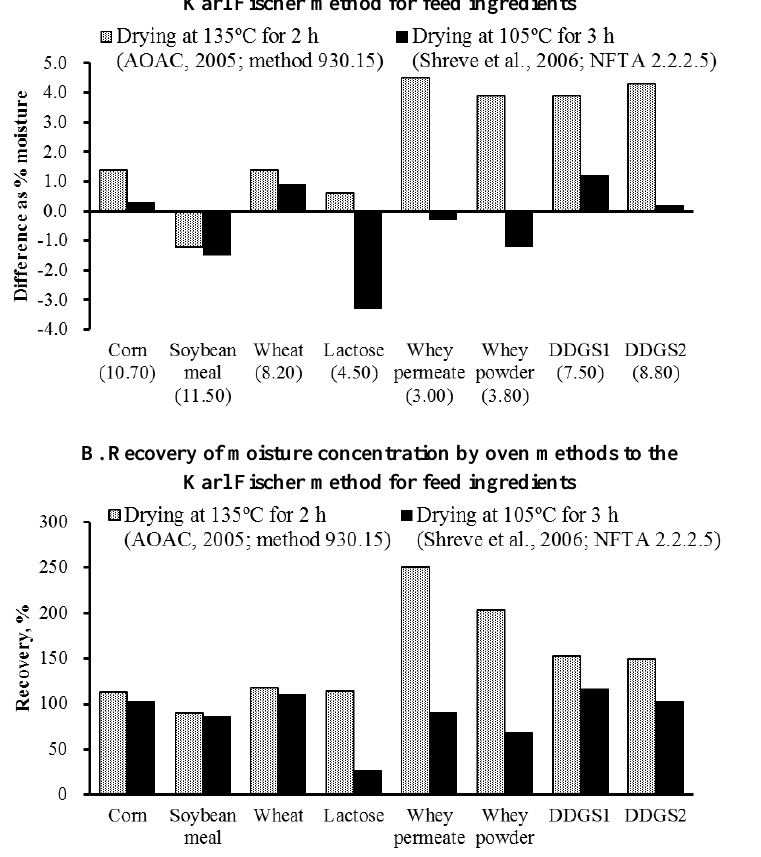
Figure 1. (A) Difference of moisture concentration between oven methods and with the Karl Fischer method, and (B) the recovery of moisture by oven methods to the Karl Fischer method in Exp. 2. The values in the parenthesis in Figure 1A represent the moisture concentration of each ingredient measured by the Karl Fischer method. DDGS, distillers dried grains with